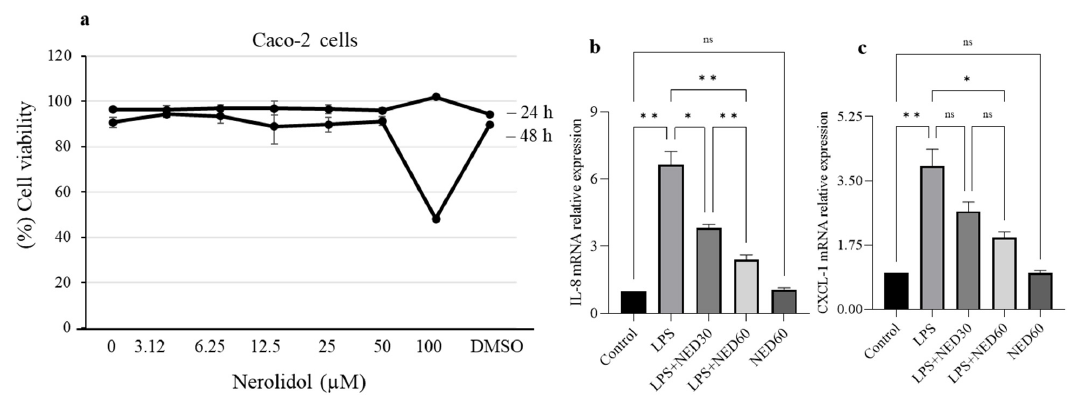
Figure 6. E ff ect of NED on cell viability and proin fl ammatory chemokine mRNA expression in LPS- Figure 6. Effect of NED on cell viability and proinflammatory chemokine mRNA expression in stimulated Caco-2 cells. The concentration-dependent cytotoxic e ff ects of NED were evaluated for LPS-stimulated Caco-2 cells. The concentration-dependent cytotoxic effects of NED were evaluated 24 h and 48 h ( a ). LPS stimulation signi fi cantly increases proin fl ammatory chemokine (IL-8 & CXCL- for 24 h and 48 h ( a ). LPS stimulation significantly increases proinflammatory chemokine (IL-8 & 1) mRNA expression ( b , c ). NED treatment (30 and 60 µM) signi fi cantly decreased it. Data expressed CXCL-1) mRNA expression ( b , c ). NED treatment (30 and 60 µ M) significantly decreased it. Data as mean ± SEM (n = 6). * p ≤ 0.05, ** p ≤ 0.01, and ns indicates not signi fi cant. expressed as mean ± SEM (n = 6). * p ≤ 0.05, ** p ≤ 0.01, and ns indicates not significant.